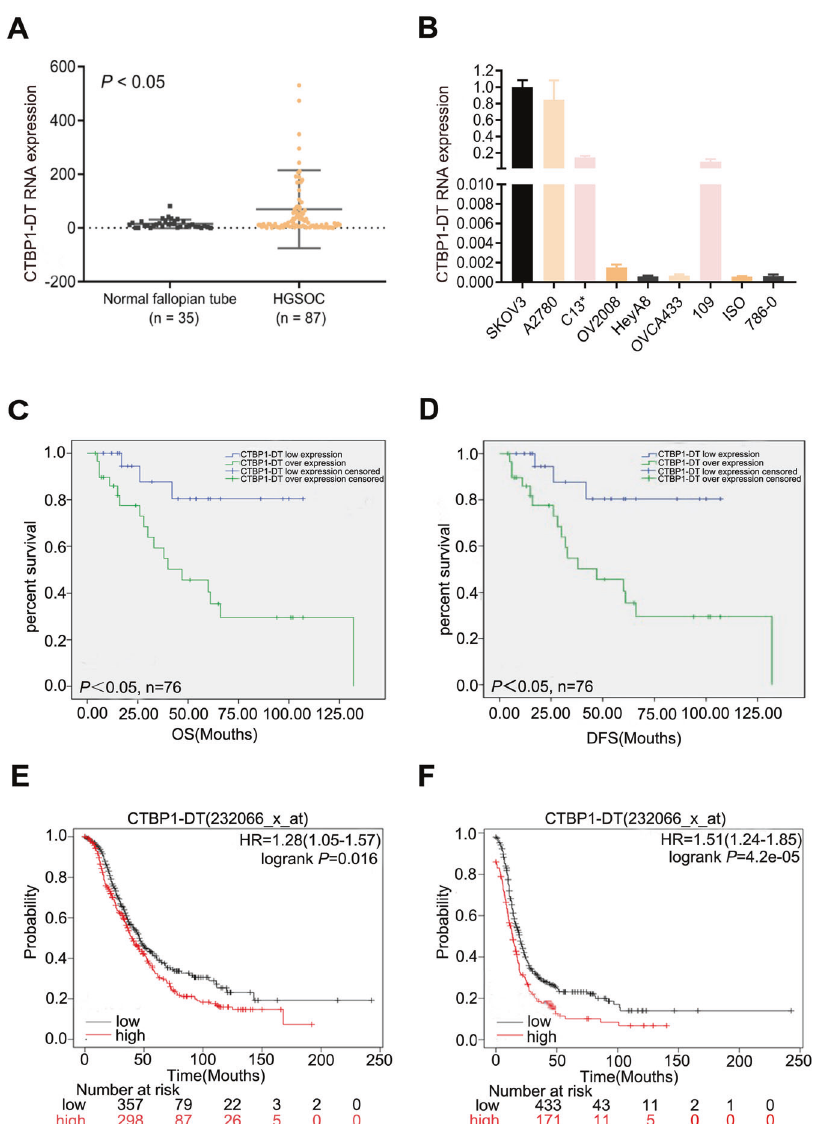
Fig. 1 LncRNA CTBP1-DT is upregulated in HGSOC cells and positively correlates with poor prognosis in HGSOC patients. A The expression of lncRNA CTBP1-DT was detected in 87 HGSOC tissues and 35 normal fallopian tube by qRT-PCR. B The relative expression of lncRNA CTBP1-DT in ovarian carcinoma cell lines (SKOV3, A2780, C13*, OV2008, HeyA8 and OVCA433), oesophageal carcinoma cells (109), angiosarcoma cells (ISO) and renal clear cell carcinoma cells (786 – 0) was detected by qRT-PCR. C , D Kaplan – Meier plots were used to determine the association between the lncRNA CTBP1-DT expression level and the OS/DFS of patients with HGSOC. E , F Log-rank test was used to determine the association between lncRNA CTBP1-DT expression level and the survival times in patients with HGSOC in the TCGA HGSOC datasets. Data are presented as the mean ± SEM. * P < 0.05, ** P < 0.01, *** P <